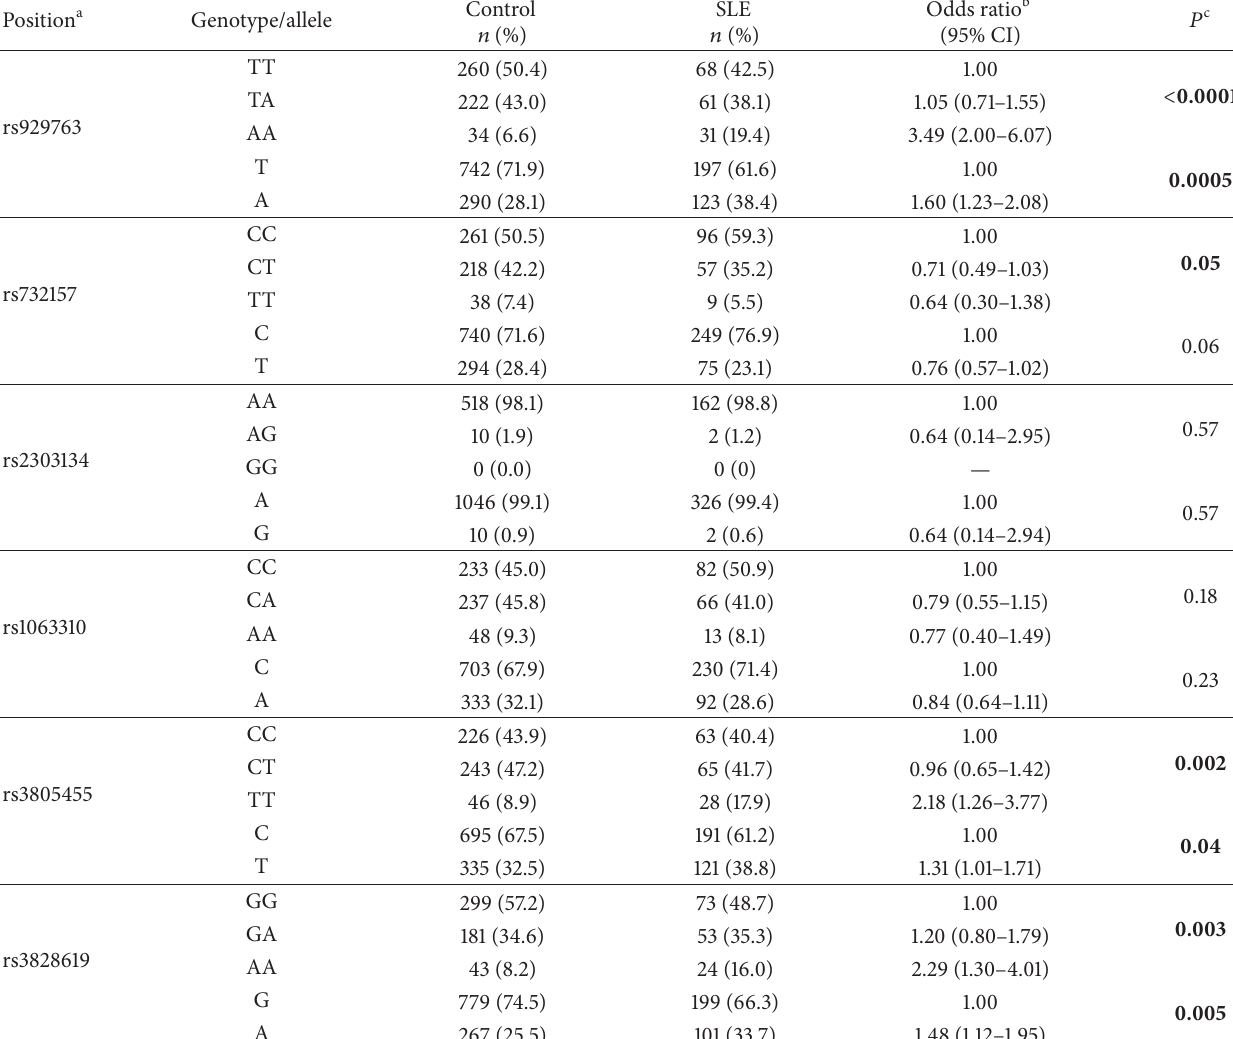
Table 2: Genotype and allele analyses of the GABRP gene SNPs in SLE patients and healthy controls. Position